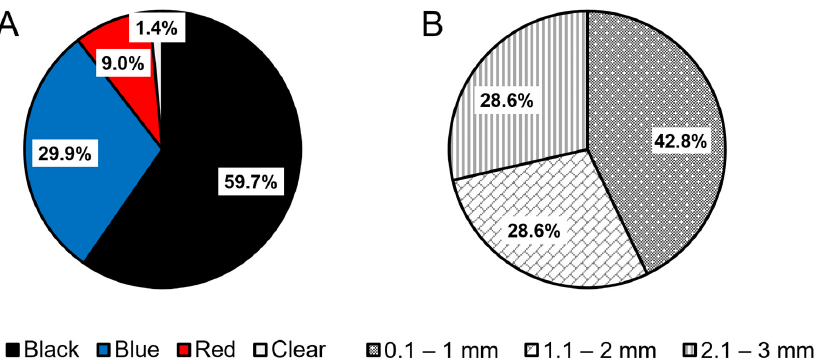
Figure 4. Microplastic composition (%) regarding color ( A ) and size ( B ) accumulated in wedge clam specimens.